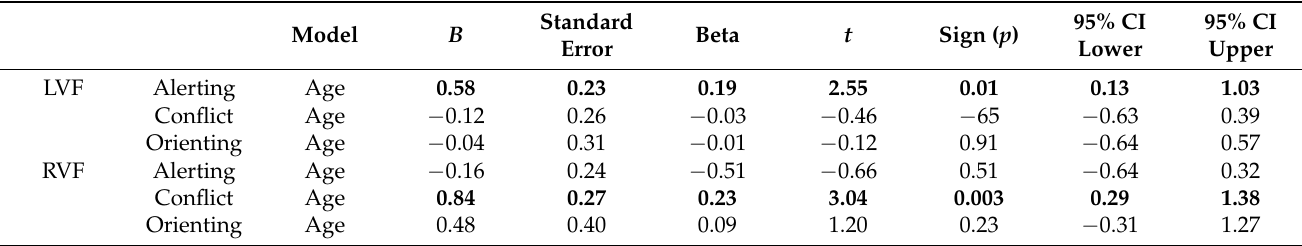
Table 4. Regression analysis considering age as an independent variable and attentional effects in the LVF and RVF as dependent variables.